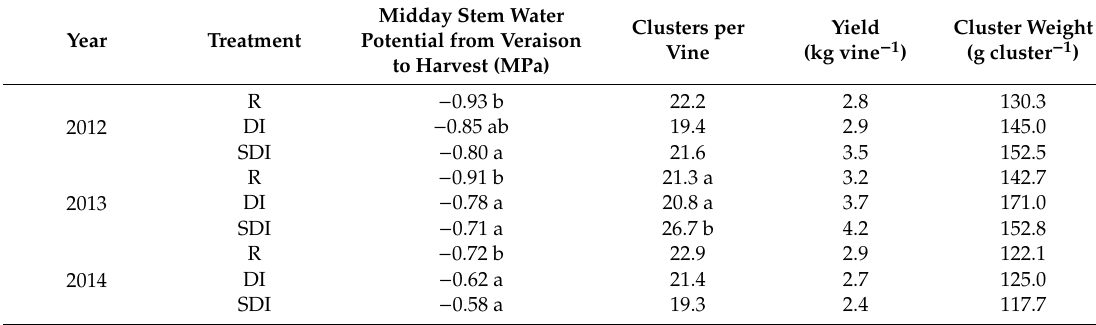
Table 2. Water status, number of clusters, yield and cluster weight of Godello vines subjected to rain-fed and irrigation conditions during three consecutive seasons (2012, 2013, and